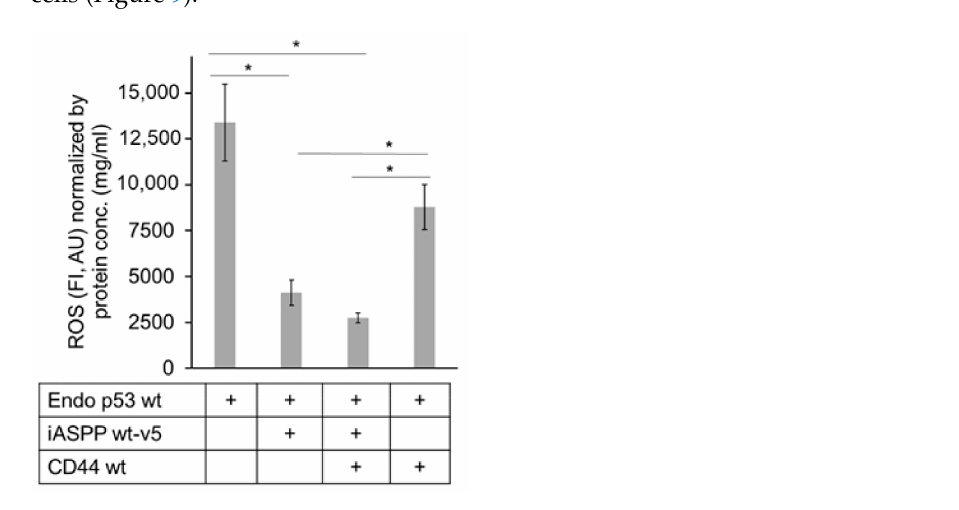
Figure 9. iASPP-CD44 complexes suppress but CD44 increases p53-mediated ROS production. V5-tagged wt iASPP (iASPP wt-v5) or CD44 were transfected individually or in combination in HEK293 cells expressing high level of endogenous p53wt, and the amount of ROS was determined. The data are plotted in bar graphs representing the mean ± SD of at least three independent experi- ments (* p < 0.05, Student’s t